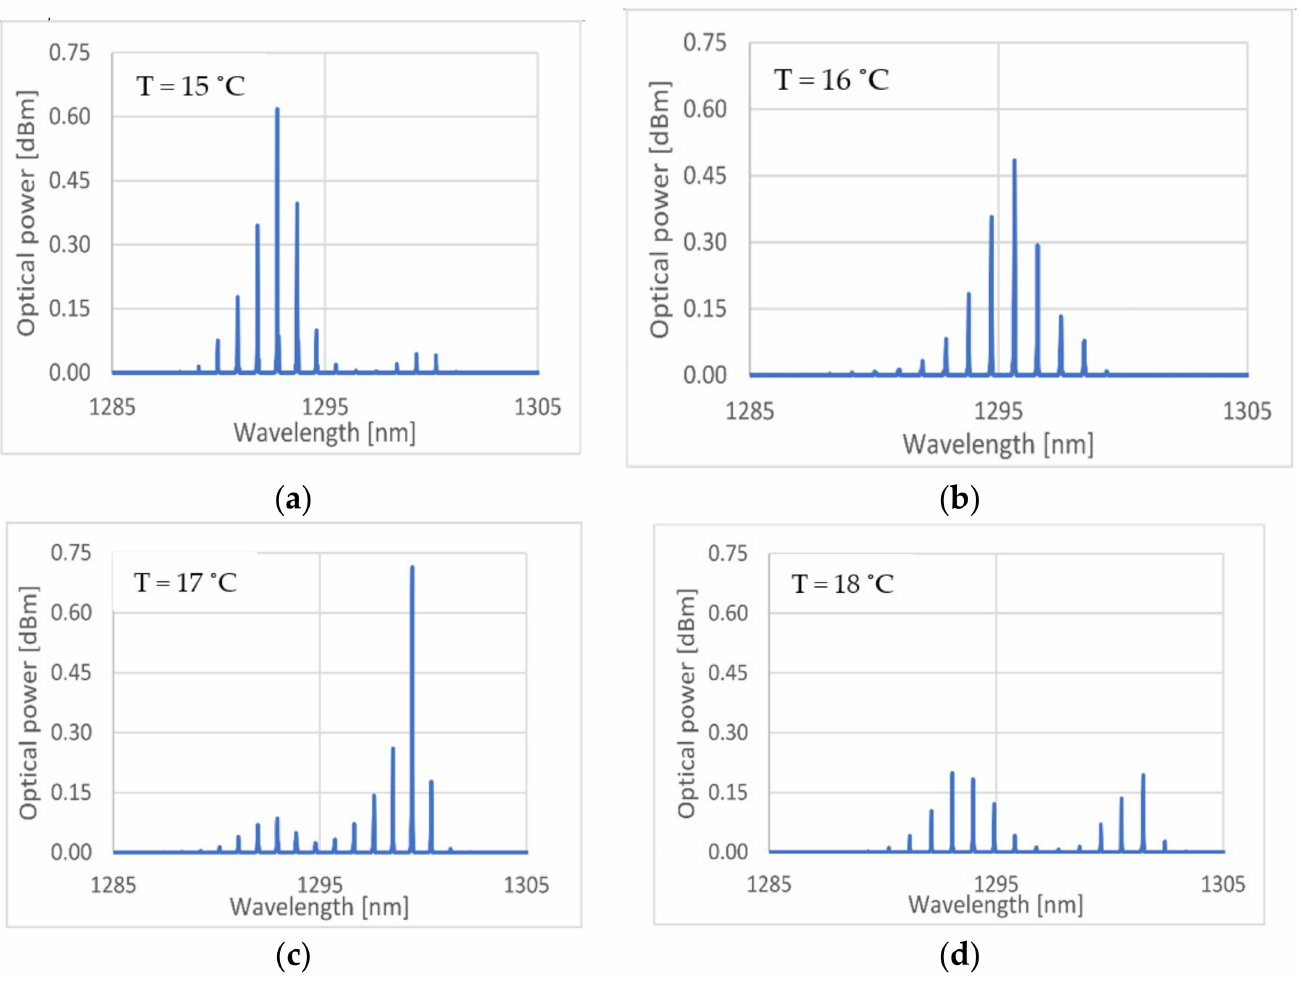
Figure 6. Spectral profiles presented by the laser, depending on the operating temperature, for a constant current of 25 mA. ( a ) Laser spectrum for a temperature of 15 ◦ C; ( b ) laser spectrum for a temperature of 16 ◦ C; ( c ) laser spectrum for a temperature of 17 ◦ C; ( d ) laser spectrum for a temperature of 18 ◦